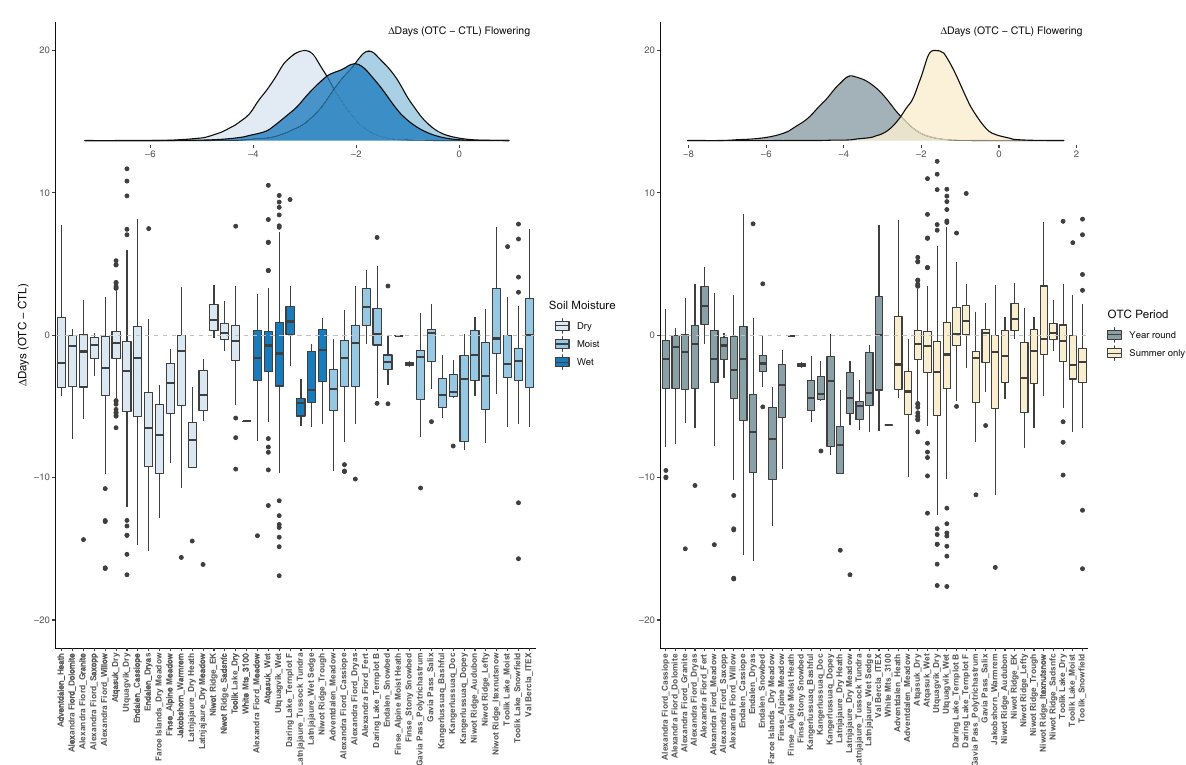
Fig. 4 Interactions with spatiotemporal factors. There was a stronger response of fl owering to experimental warming in dry versus moist sites and in sites with year-round OTCs versus summer only. Box plots of raw data indicate median (middle line), 25th, 75th percentile (box), and 5th and 95th percentile (whiskers) as well as outliers (single points). Biological replicates ( n ) for each subsite can be found in Supplementary Table 6c. The y axis of box and whisker plots and the x axis of density plots show the difference (in days) in the timing of fl owering for plants growing in OTC versus CTL plots. Box and whiskers plots are plotted by subsite (all species and years). Colors represent either the soil moisture (wet, moist, dry), or the period of OTC deployment (year-round, summer only) for each subsite. Gray dotted lines denote zero difference (no change) in the timing of phenology between OTC and CTL plots, while points above or below these lines denote a delay, or advancement, respectively. Corresponding density plots of modeled estimates for interactive effects of treatment on the timing of plant phenology are shown above box and whisker plots. Created using the ggplot2 package (v 3.3.2) 106 in